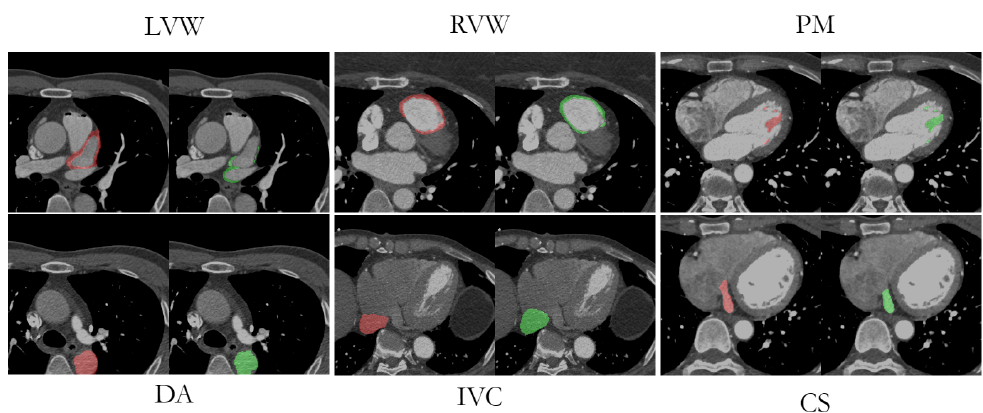
Figure 8. An example of original images from LVW, RVW, PM, DA, IVC, and CS dataset with an overlay of successful segmentation prediction (red) and corresponding GT